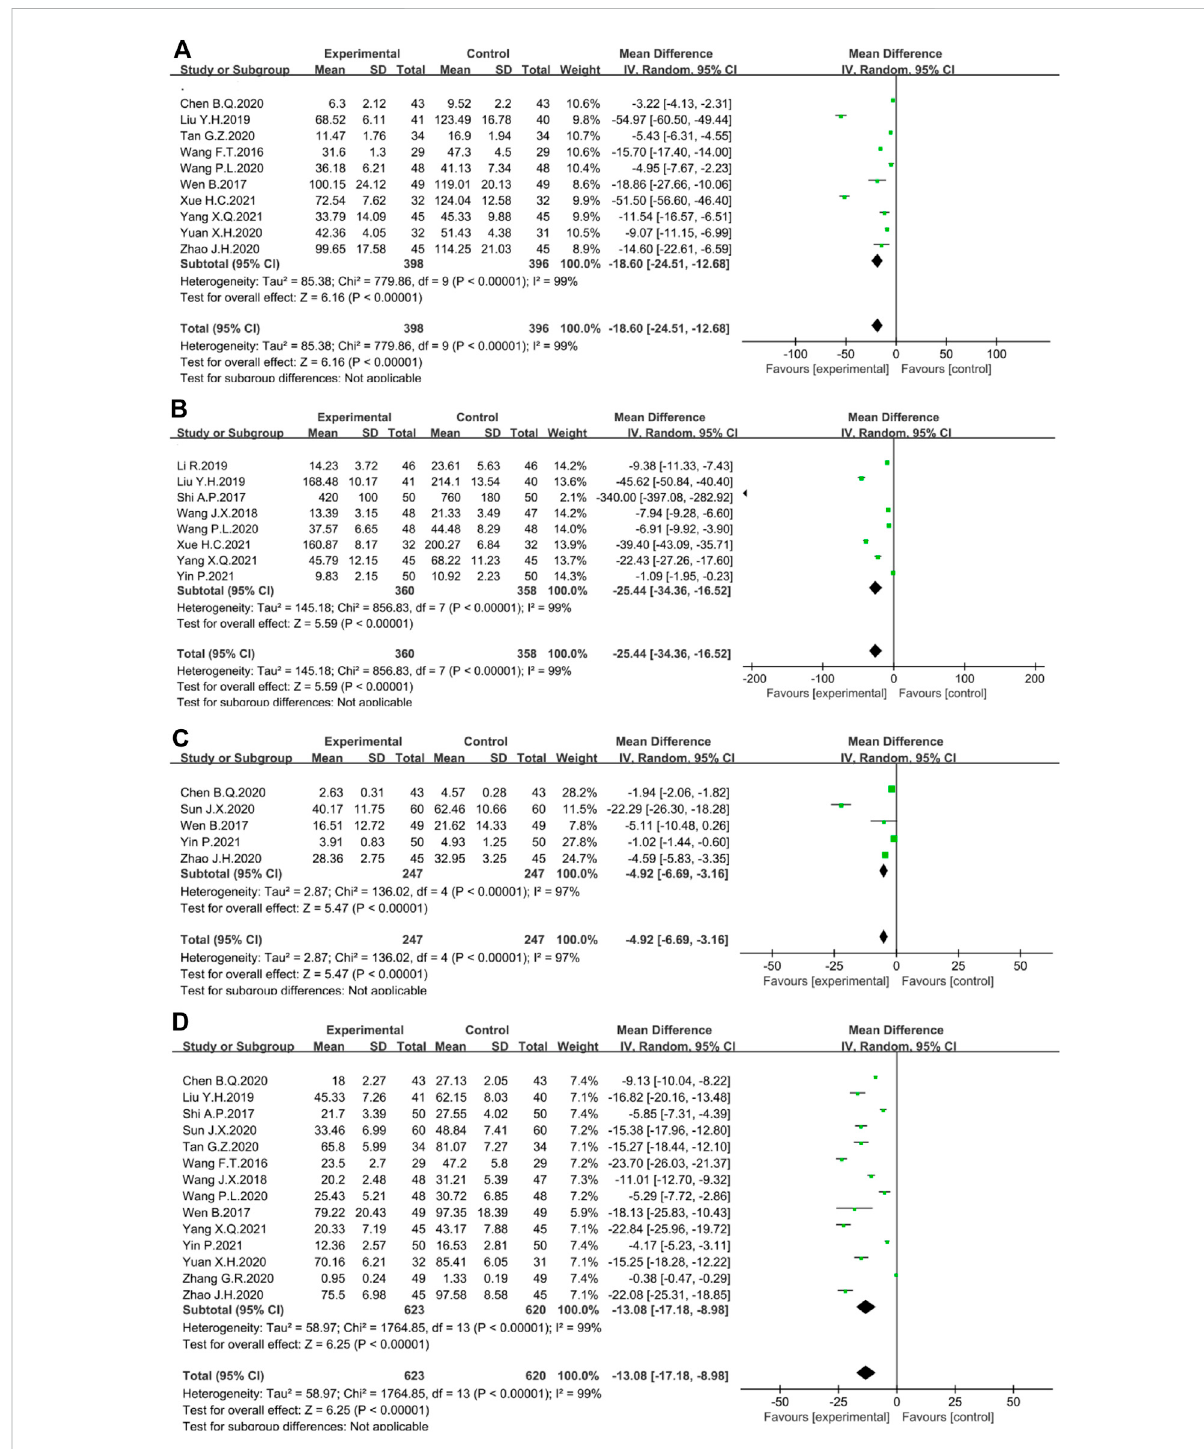
FIGURE 10 Forest plot displaying the results of the Meta-analysis for in fl ammation-related cytokines and protein. The results of (A) IL-6; (B) IL-8; (C) IL-1 β ; (D) TNF- α ; (E) CRP; (F)